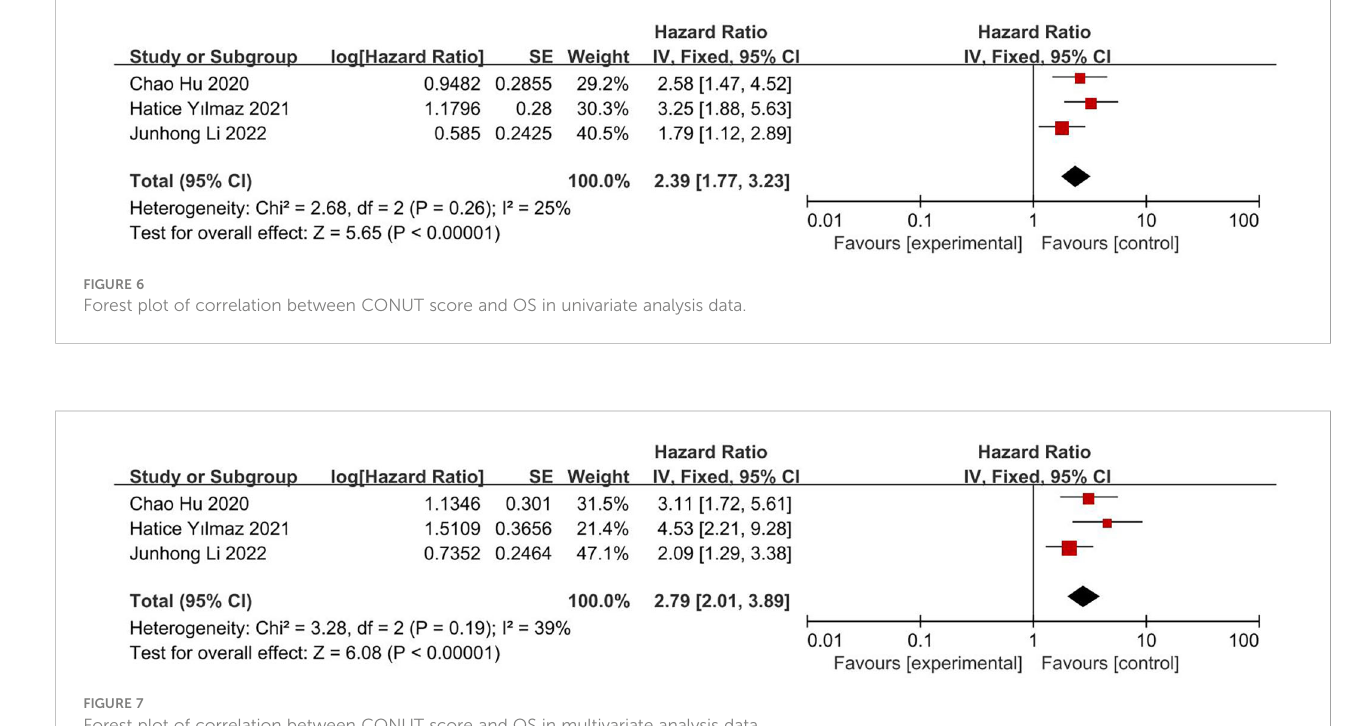
FIGURE 7 Forest plot of correlation between CONUT score and OS in multivariate analysis